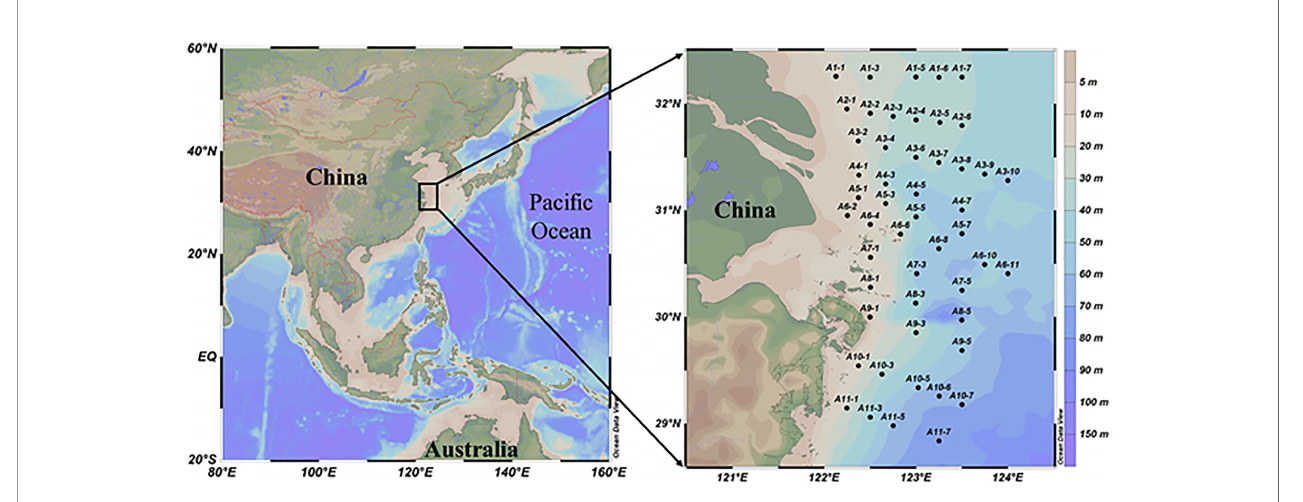
FIGURE 1 | A map of the study areas showing the sampling